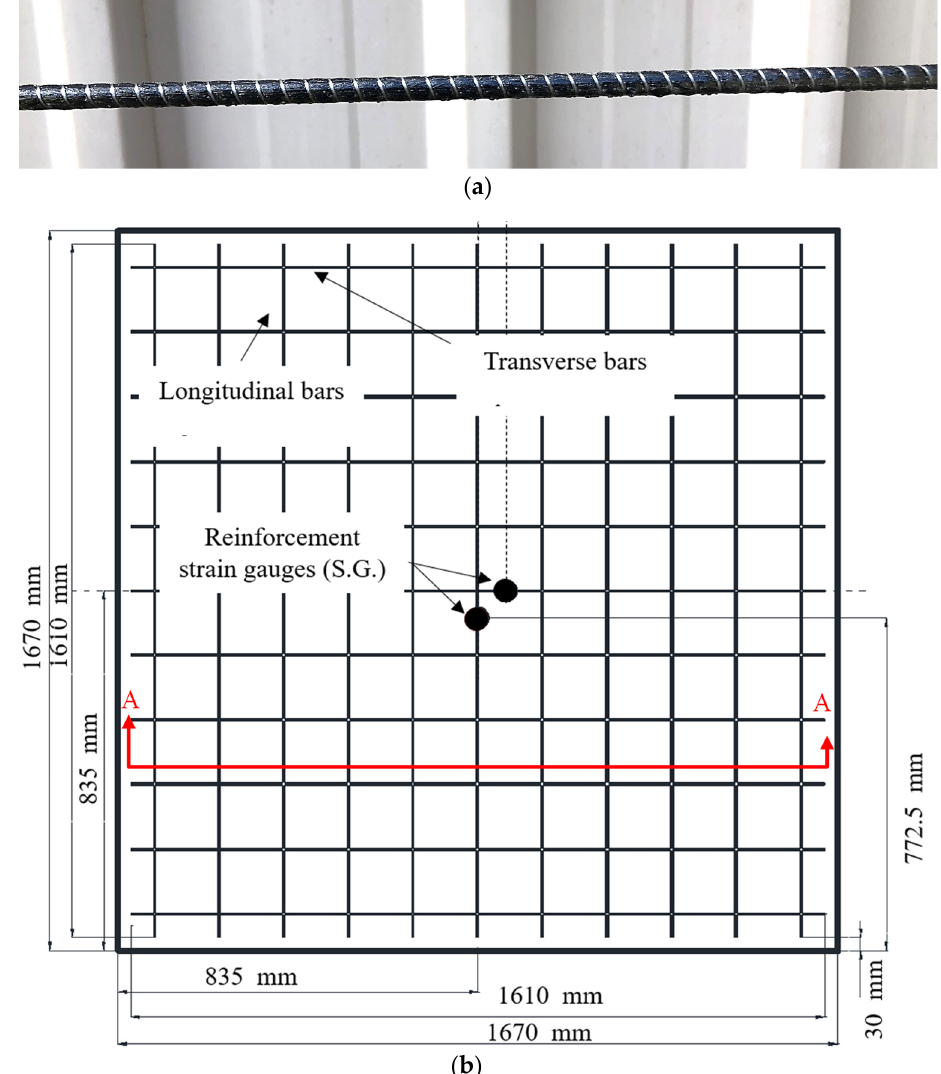
Figure 1. Reinforcement detailing, and the dimensions of the concrete slab. ( a ) deformed BFRP re- bar; ( b ) reinforcement details. Table 2. Compressive strength of concrete and details of